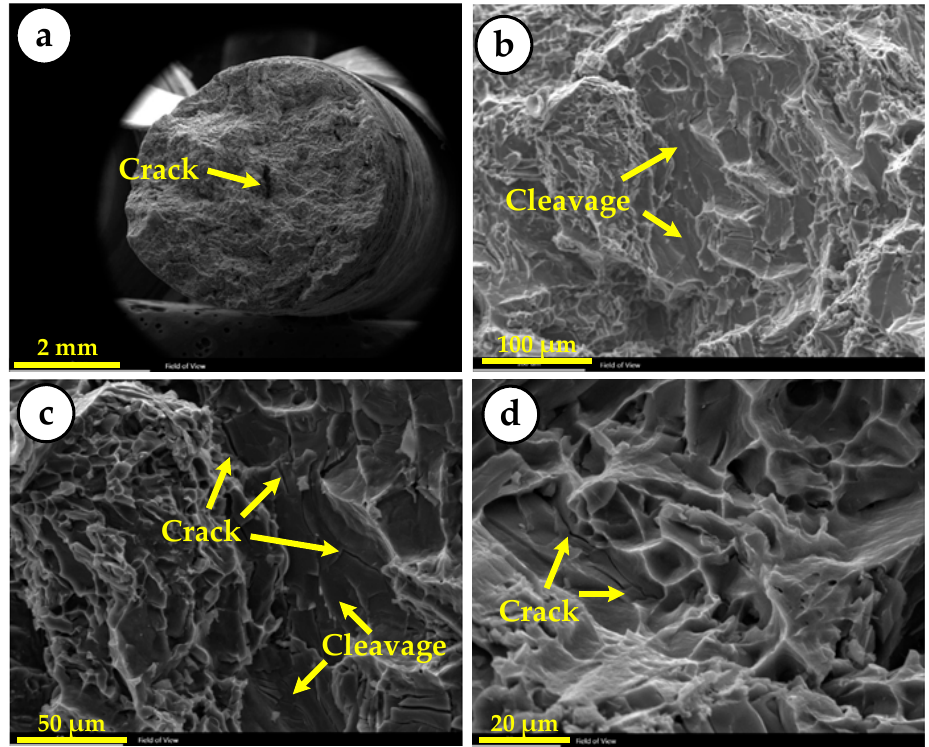
Figure 9. SEM micrographs of the fractured surface of COMP2, ( a ), at different scales of 100 µm ( b ), 50 µm ( c ), and 20 µm ( d ).